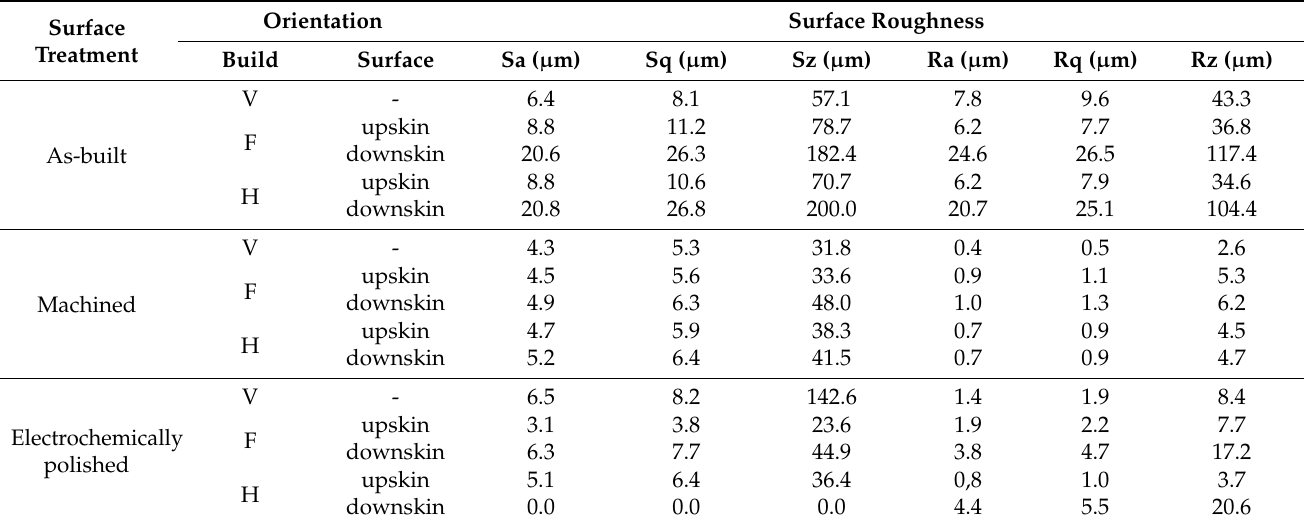
Table 8. Surface roughness for as-built, machined, and electrochemically polished samples in ver- tical, 45 ◦ , and horizontal orientations. For F and H samples, up- and downskin surfaces were measured